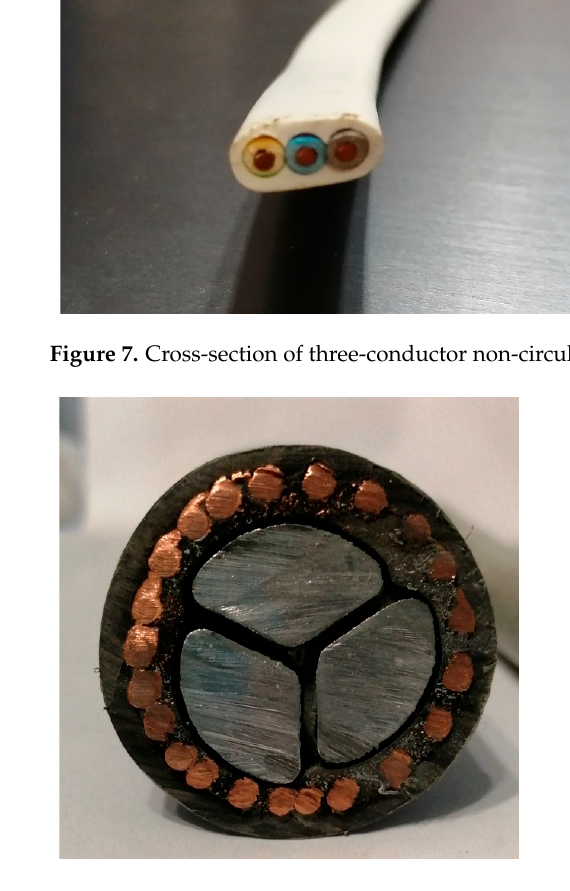
Figure 8. Cross-section of three-conductor sector-shaped cable.